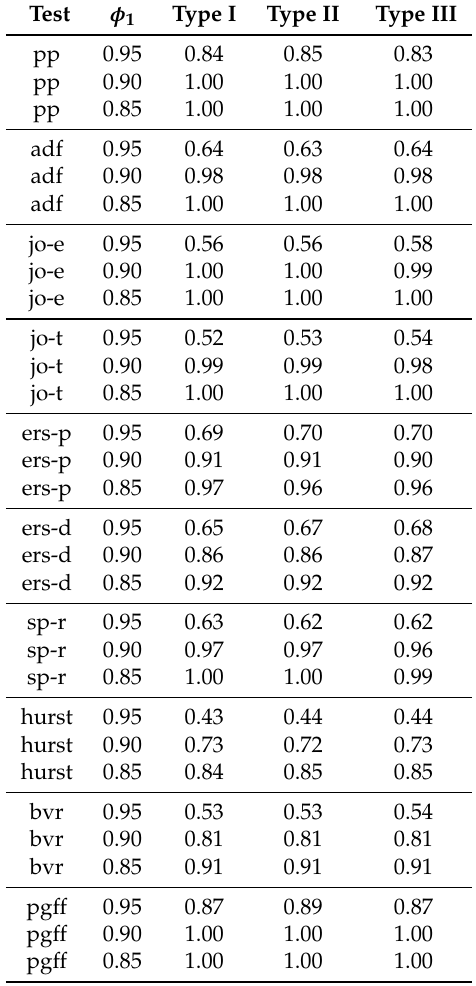
Table 9. Power of cointegration tests for Monte Carlo settings of Type I, Type II and Type III, as described in Subsection